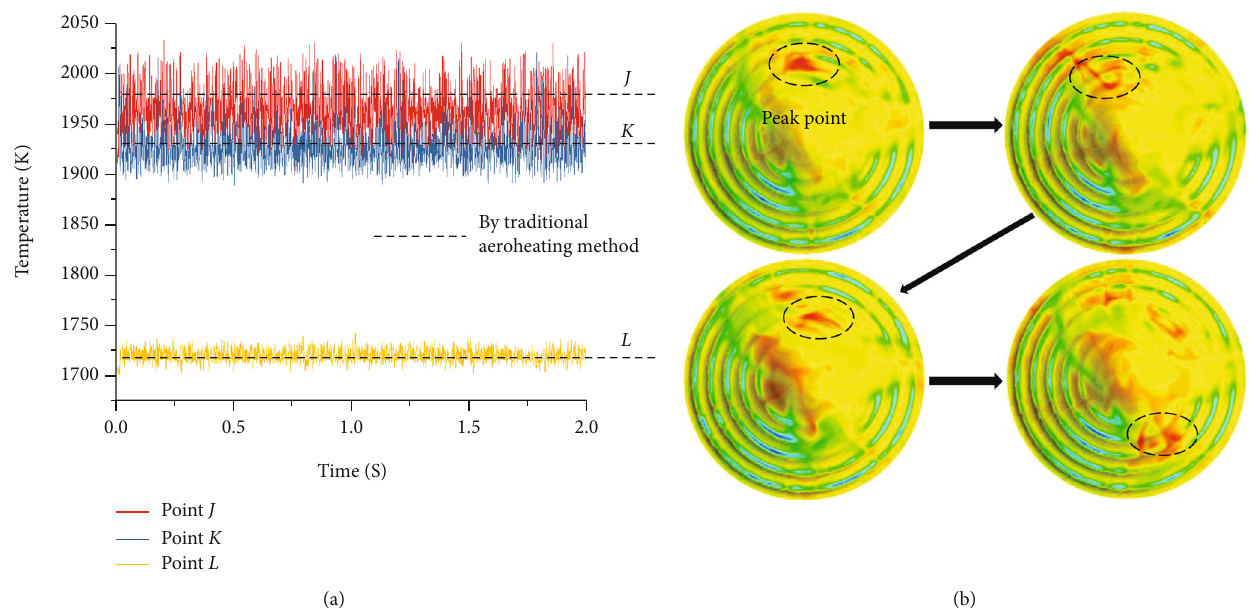
Figure 15: Temperature pulsation on windward: (a) curves; (b) nephograms.